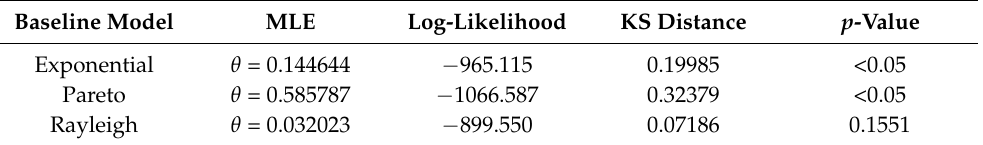
Table 11. Goodness-of-fit results for real